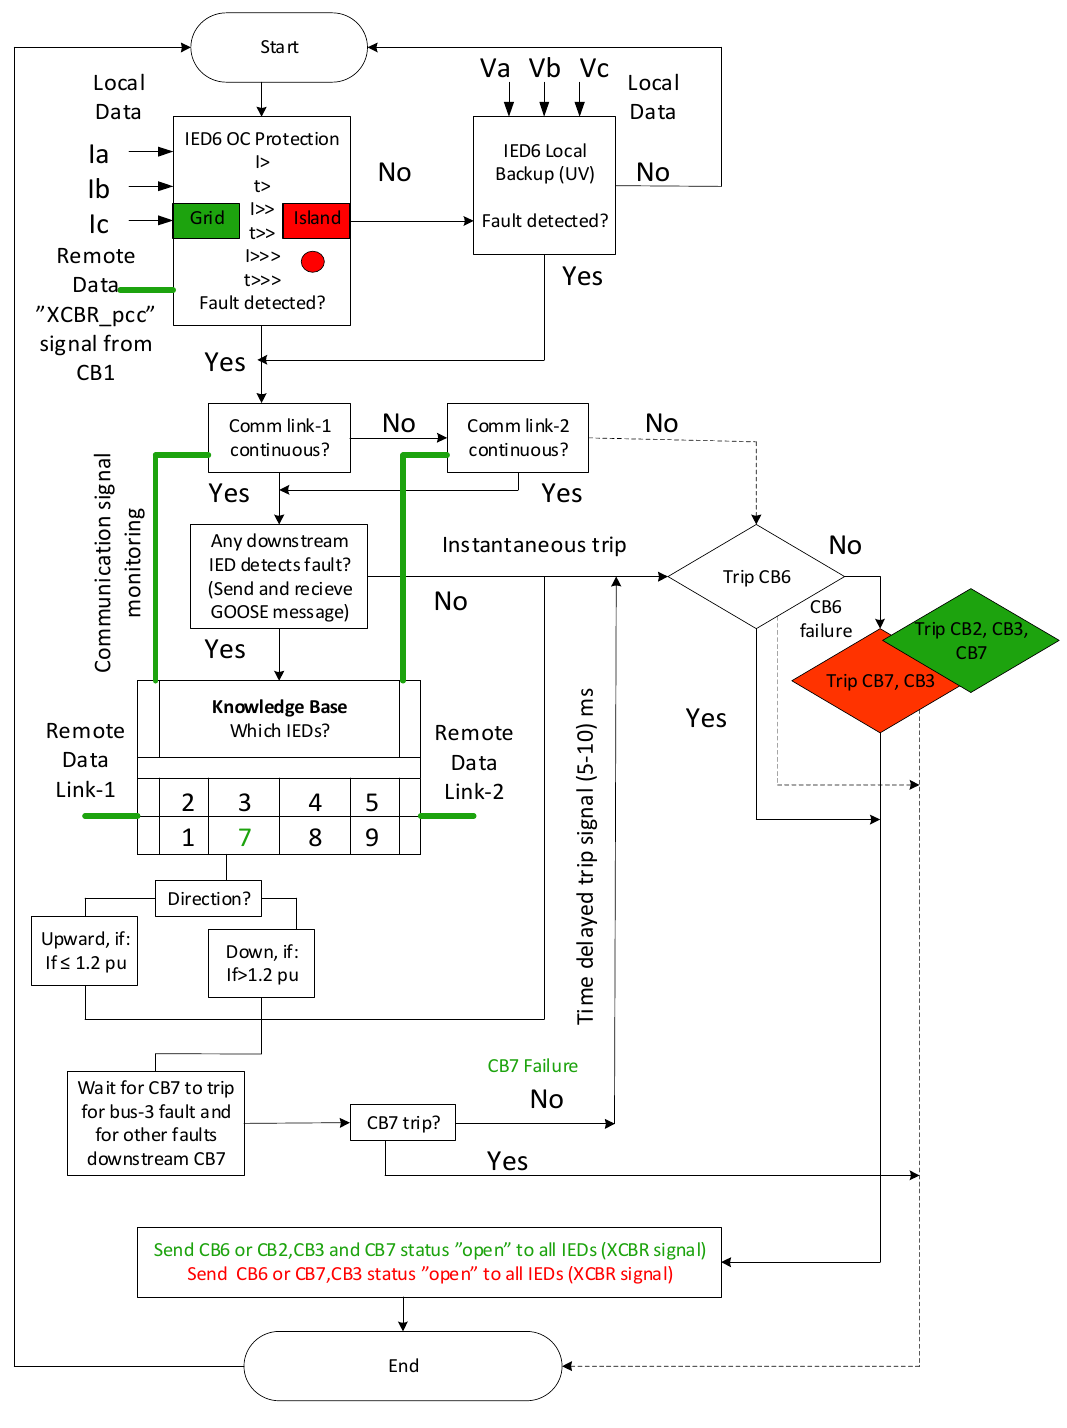
Figure 7. Flowchart for communication-based adaptive IED6 providing primary protection for fault F2 and remote backup for all downstream faults in both grid-connected and islanded modes.